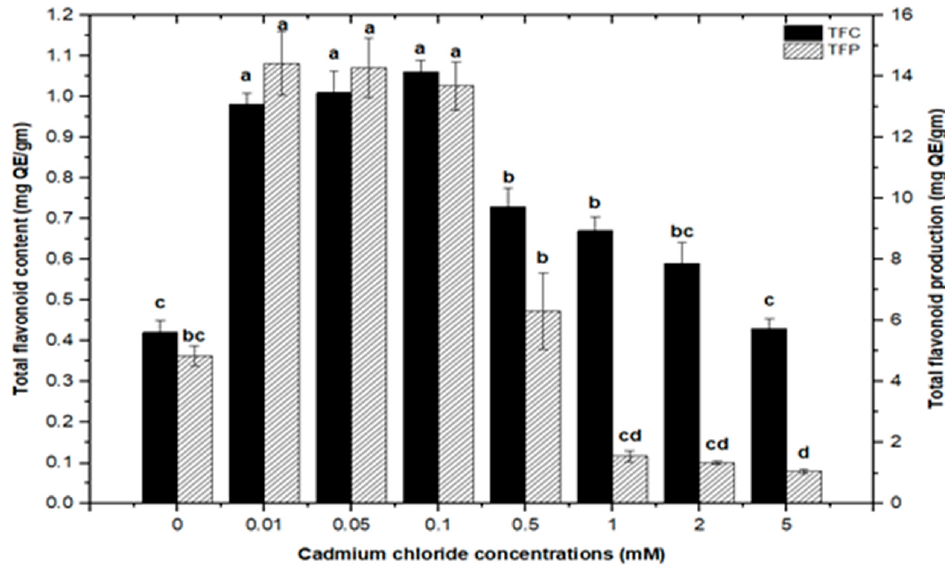
Figure 7. Total flavonoids contents and flavonoids production of F. indica calli elicited with seven different concentrations of cadmium chloride and control. All the values are mean ± SE. Bars labeled with different letters (LSD values) exhibit significant variation ( α < 0.05).